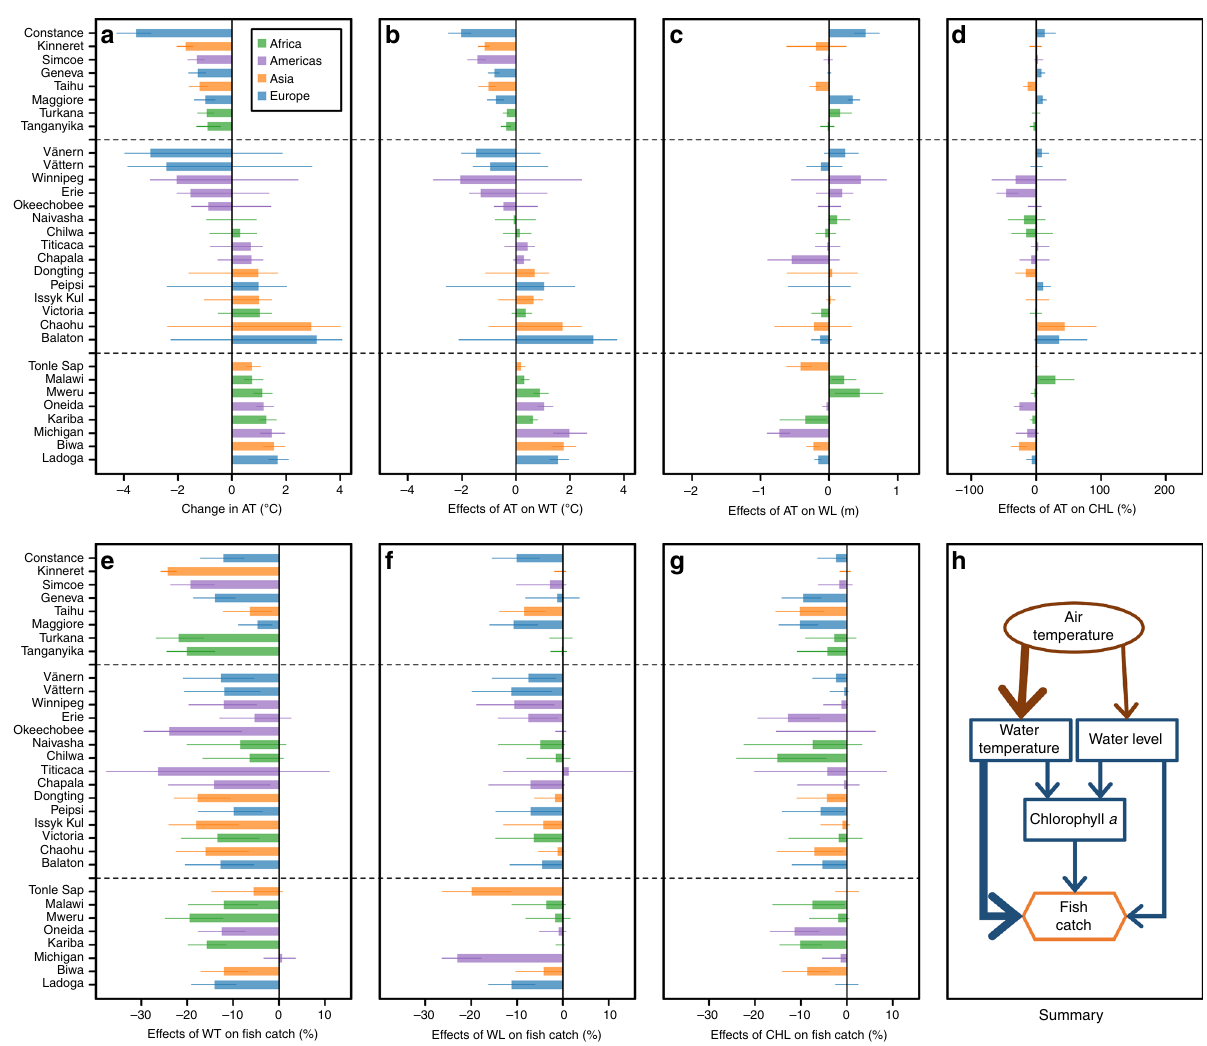
Fig. 4 Assessment for effects of air temperature on fi sh catches across the 31 study lakes. Changes or effects were calculated as differences (actual or relative) from the 1970 – 2014 medians. a shows simulated changes in air temperatures (AT) associated with a 25% decrease in fi sh catches. b – d show simulated effects of changes in AT on water temperature (WT), water level (WL), and chlorophyll a (CHL). e – g depict how simulated effects of WT, WL, and CHL, in response to changing AT, affected fi sh catches. h summarizes these linkages within a subset of the Bayesian networks model that demonstrates the effects of AT, where the width of each arrow is a qualitative indicator of the strength of the hypothesized causal effects. In a – g , bars represent simulated median changes and error bars represented fi rst and third quartiles of the simulated changes. Dashed lines divide the lakes into “ positive ” (top 8 lakes), “ mixed ” (middle 15 lakes), or “ negative ” (bottom 8 lakes) associations between AT and fi sh catches, based on one-tailed 75% credible intervals, as indicated by error bars in a . For positive lakes, a 25% decrease in fi sh catches was associated with colder AT. For mixed lakes, a 25% decrease in fi sh catches was associated with both colder and warmer AT. For negative lakes, a 25% decrease in fi sh catches was associated with warmer AT. Source data for a – g are provided as a Source Data fi